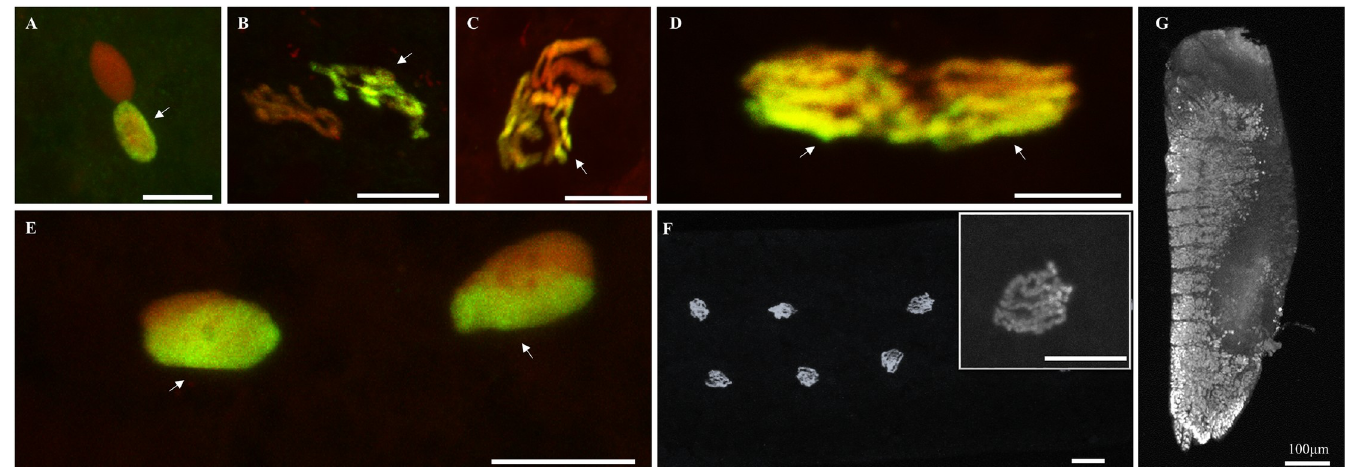
Fig 1. Normal embryogenesis in C . pipiens : From first nuclear divisions to segmentation. Paternal chromatin appears in green/yellow (acetylated histone H4 labelling is dominant) and maternal chromatin appears in red (propidium iodide labelling is dominant). (A) apposition of maternal and paternal pronuclei, (B) chromatin under condensation, (C) condensed chromatin, (D) first mitotic division anaphase (maternal and paternal chromosome segregate independently), (E) two nuclei following the first division, (F) normal diploid development 1 hour after oviposition, six diploid nuclei are visible after 1h development, (G) segmented embryo after 24 hours of development. White arrows indicate the paternal chromatin. Confocal stacks were obtained on embryos from several fertile intra-line crosses due to the difficulty to obtain all the early embryonic stages from each cross (S2 Table). Scale bar is 10 μ m.